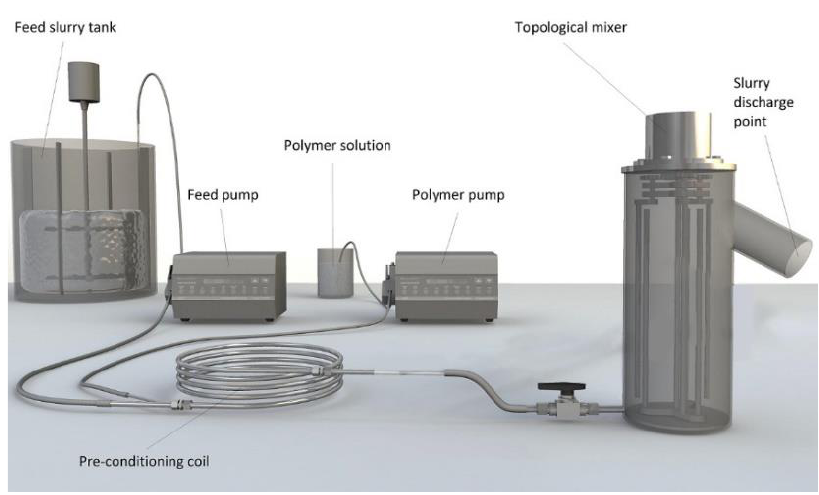
Figure 2. Tapered shear setup for polymer addition to high-solids suspensions